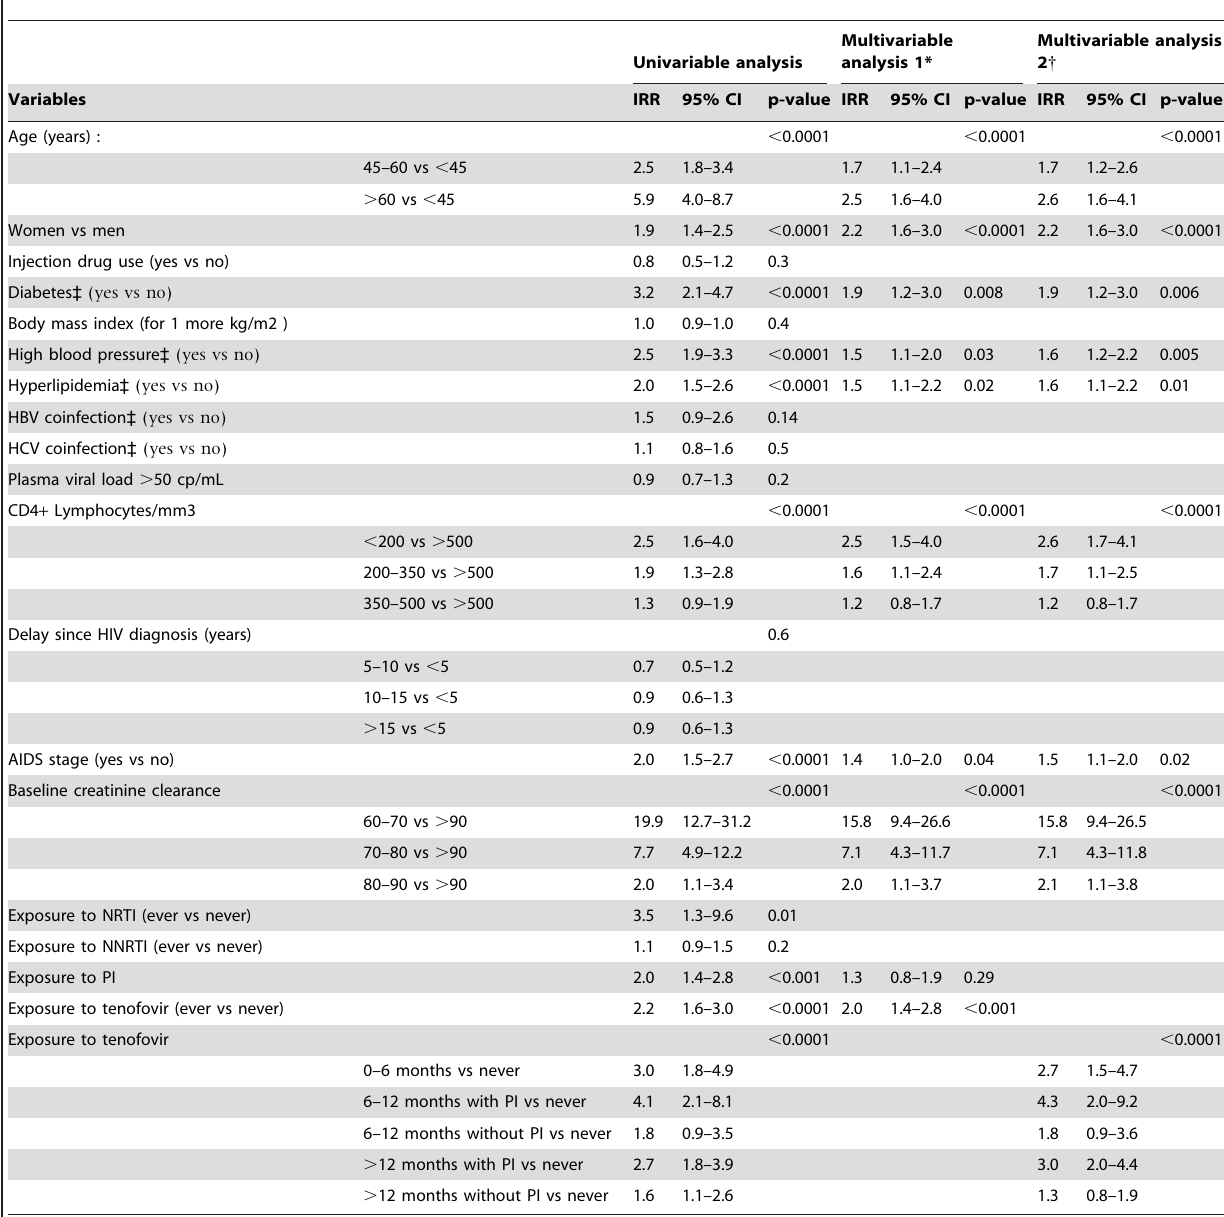
Table 2. Factors associated with CKD in ANRS CO3 Aquitaine Cohort, N=4350 patients and 209